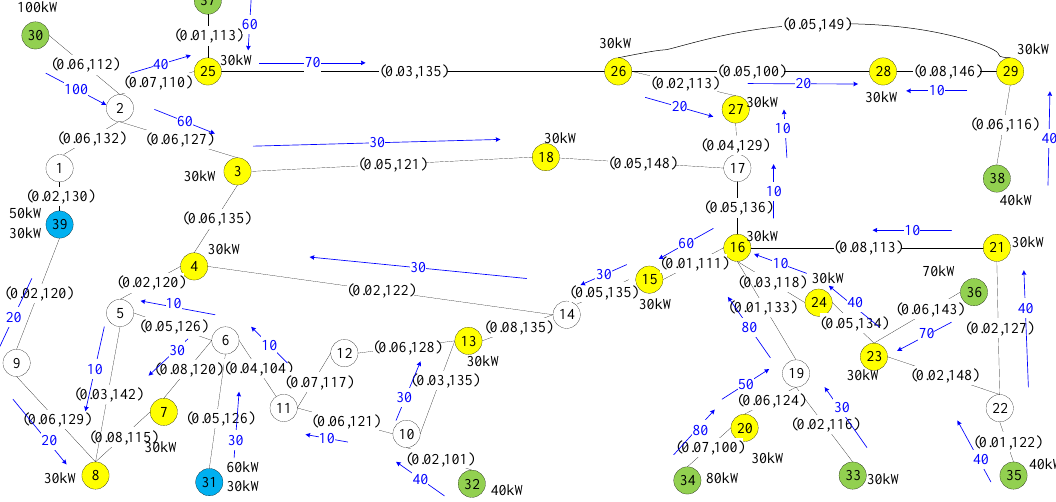
Figure 12. Optimal path selection and source-load matching on the IEEE39